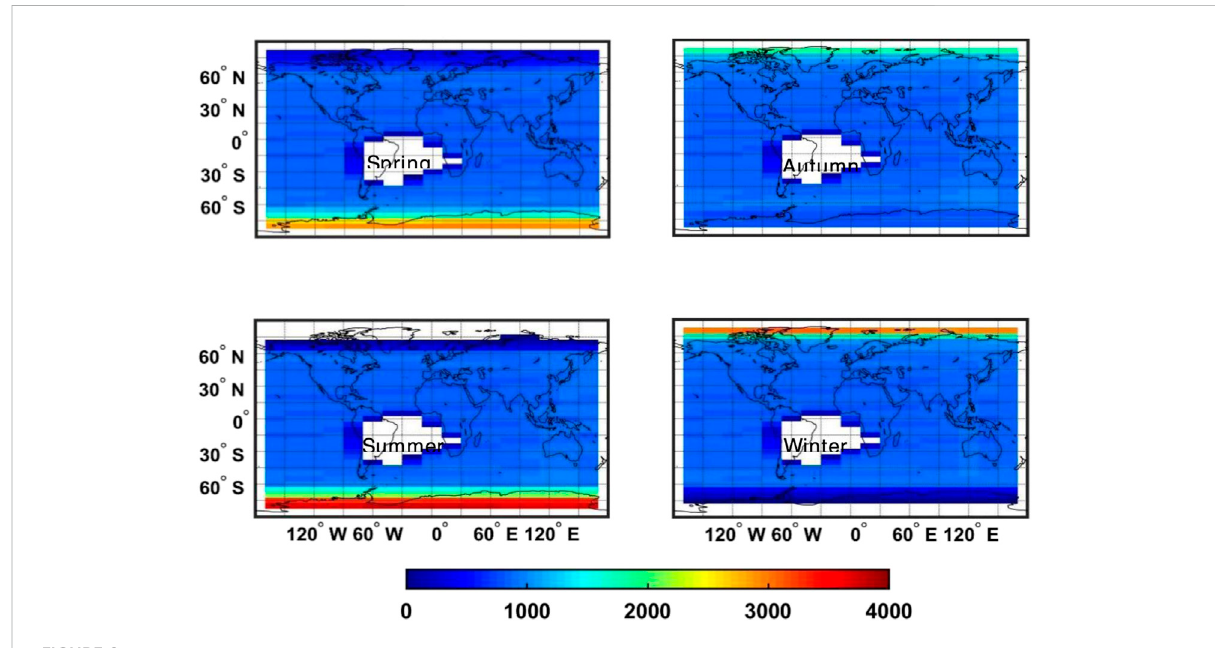
FIGURE 2 Distribution of CALIPSO number of scan lines at nighttime during 2007 – 2018 by